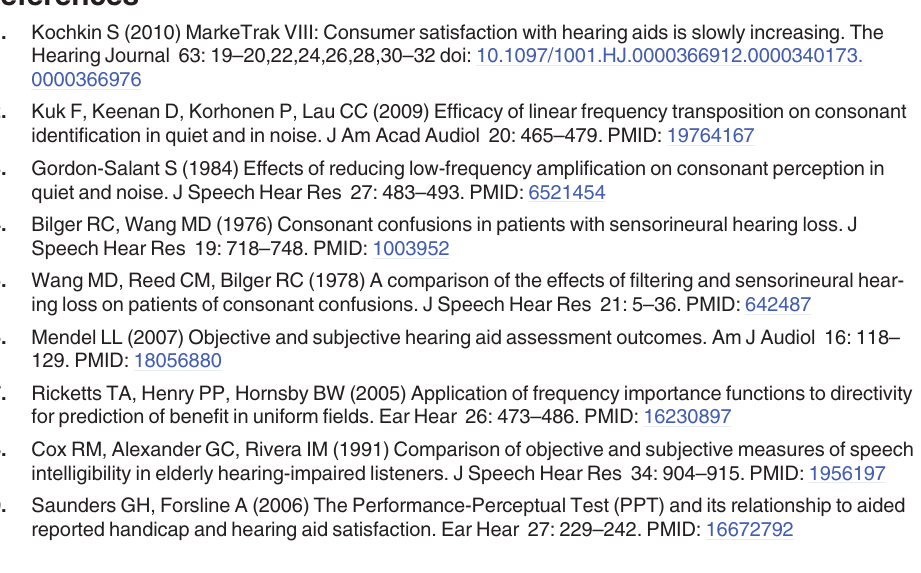
S5 Table. Hearing aid benefit for individual consonants. Unaided and aided SNR thresholds of OHI listeners for each consonant, along with the results of the ANOVA on the Aided-Un- aided difference. Average thresholds are given in dB SNR. Average dB SNR thresholds for ONH listeners (Woods et al., 2012) are given in parentheses in the first column for comparison. S6 Table. Confusion matrices for onset (S6a) and coda (S6b) consonants in unaided listen- ing conditions. S7 Table. Confusion matrices for onset (S7a) and coda (S7b) consonants in aided listening conditions. S8 Table. Correlations of pure-tone thresholds and aided thresholds for individual conso- nants. Averaged over consonant position (except for / ŋ / and /h/). Type font indicates signifi-